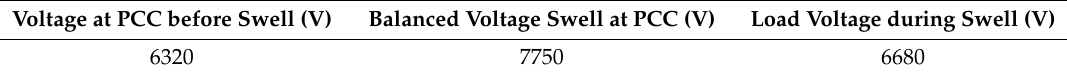
Table 2. RMS Voltage of Case 4-Balanced Voltage Swell.